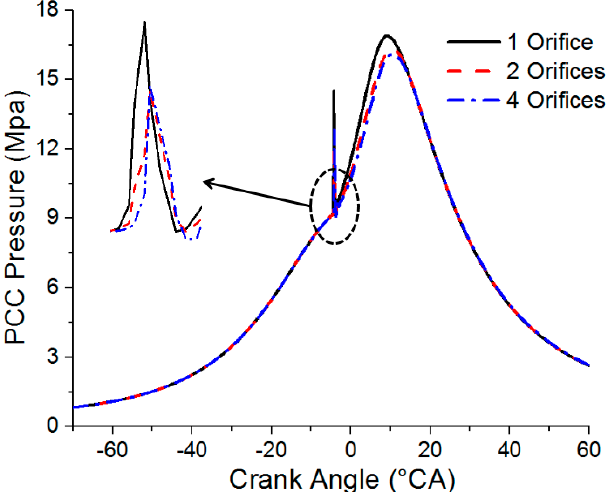
Figure 8. In-cylinder pressure and heat release rate with different injector orifices.